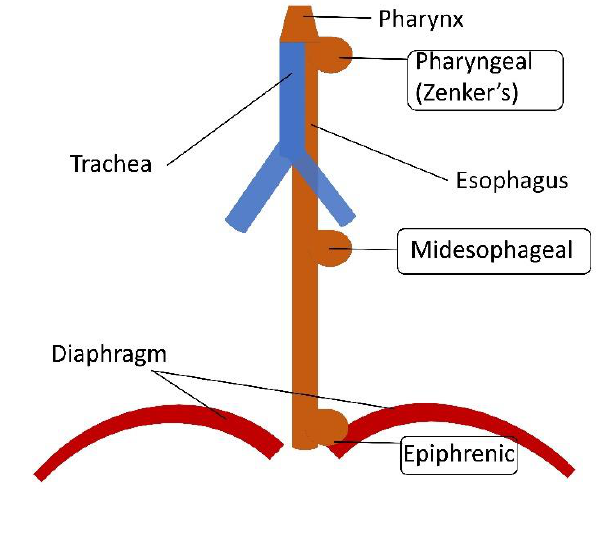
Figure 2 : Main types of esophageal